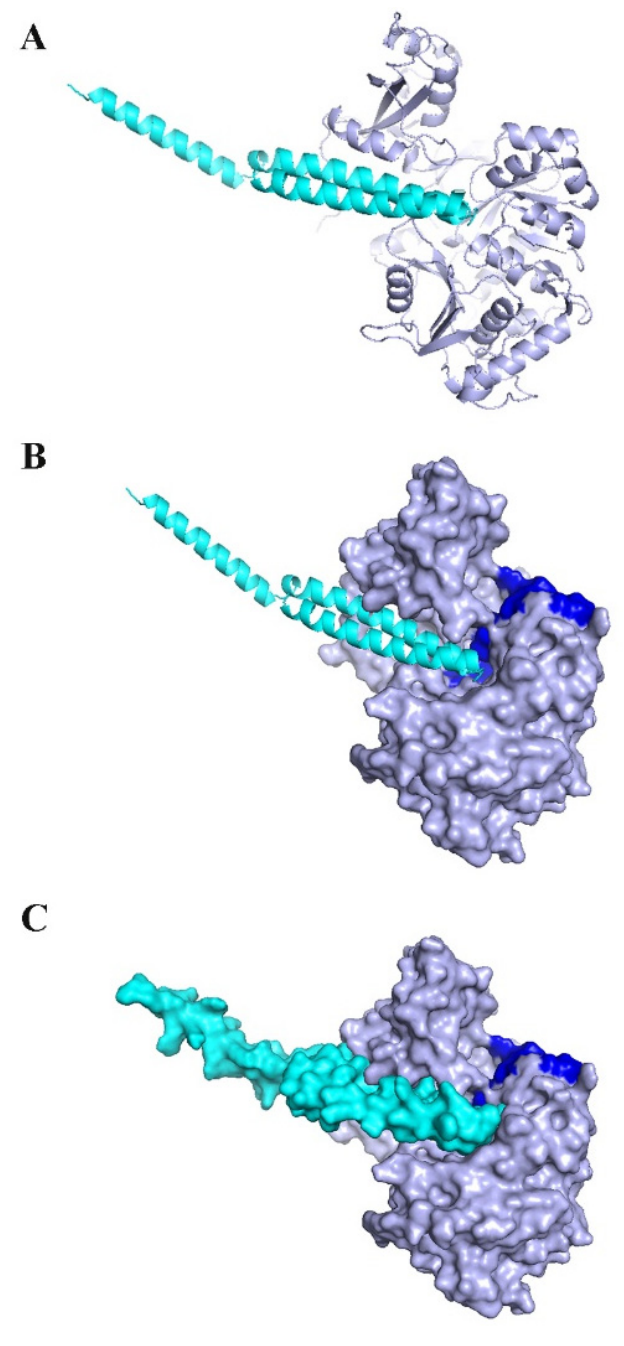
Figure 13. KAE01 EntA complexed with matrix protein. KAE01 EntA (cyan color) complexed with matrix protein (light-blue color). Highly conserved residues Gly307, Gly302, Ala278, Gly279, His308, and Tyr211 in N-terminal domain are highlighted in dark blue. ( A ) Shows Ribbon representations ( B ) KAE01 Cavity occupied surface of protein ( C ) Both are represented in surfaces